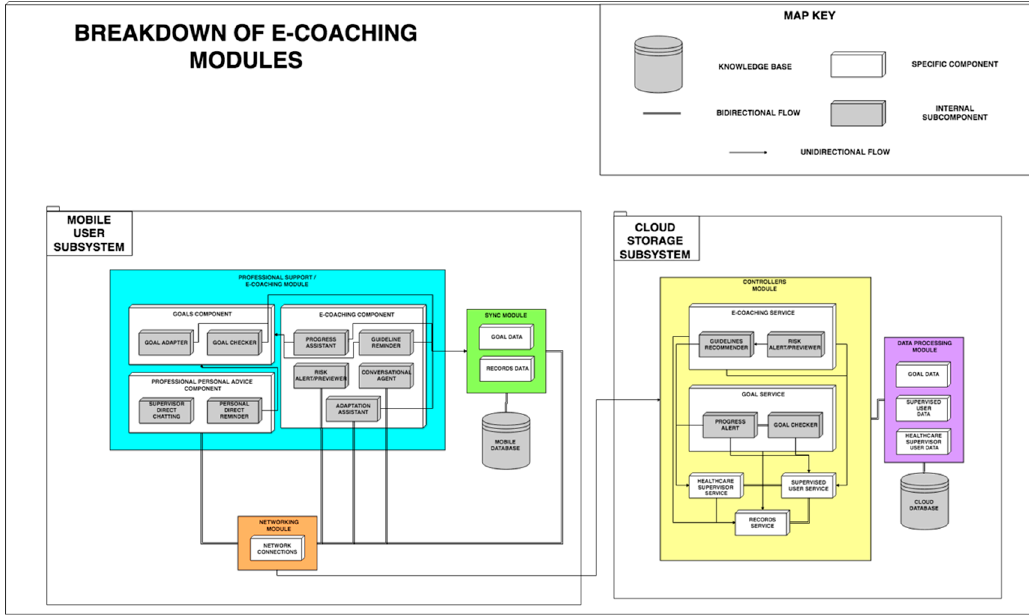
Figure 4. Breakdown of e-coaching modules.